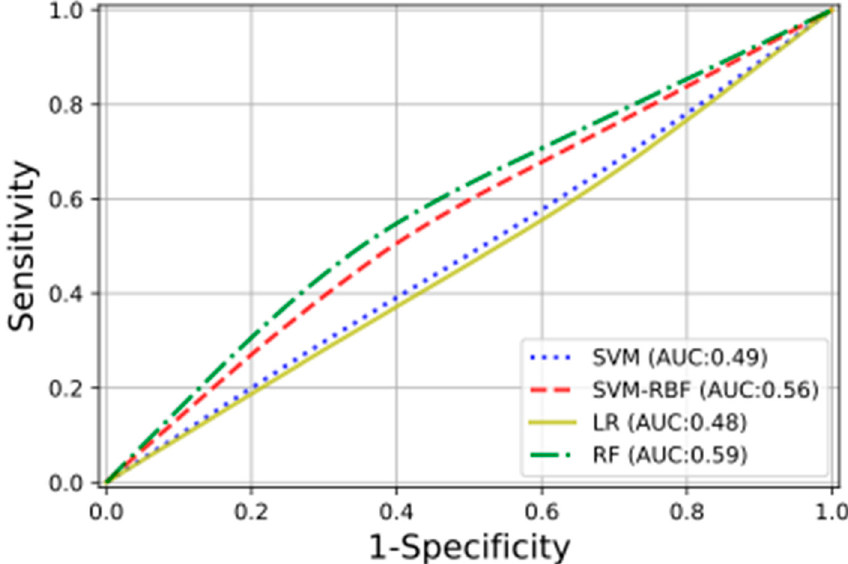
Figure 4. The plot presents the ROC curves, with the relative AUCs obtained using the following classifiers: linear support vector machine (SVM), radial basis function support vector machine (SVM-RBF), logistic regression (LR), and random forest (RF).